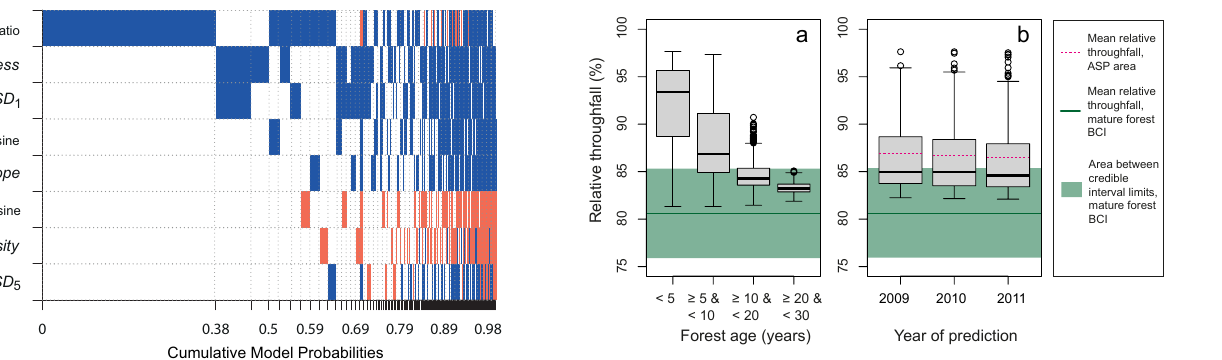
Fig. 3. Cumulative posterior model probabilities resulting from the BMA approach. The colors denote the sign of a coefficient’s ex- pected value: blue refers to a positive sign (indicating a positive relationship with relative throughfall) and red to a negative sign (indicating a negative relationship with relative throughfall). Note: the model with BA ratio as the only predictor clearly has the largest weight.